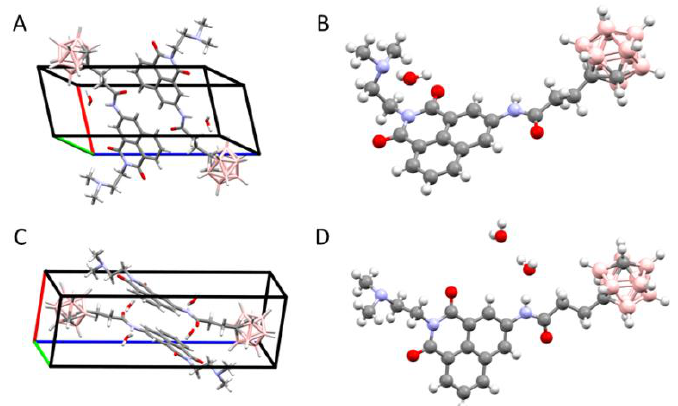
Figure 2. Crystallographic structures of carborane–naphthalimide conjugates: crystal packing and molecular structure observed for 39 ( A , B ) and 41 ( C , D ).